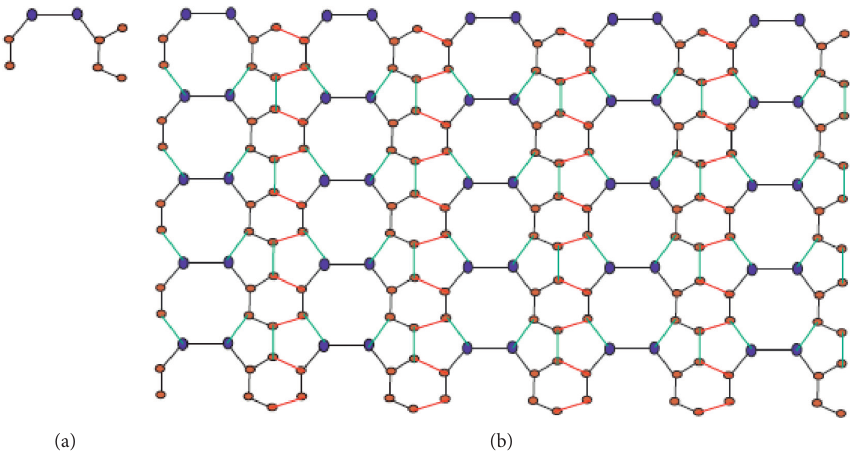
Figure 11: 2 D structure of SiC